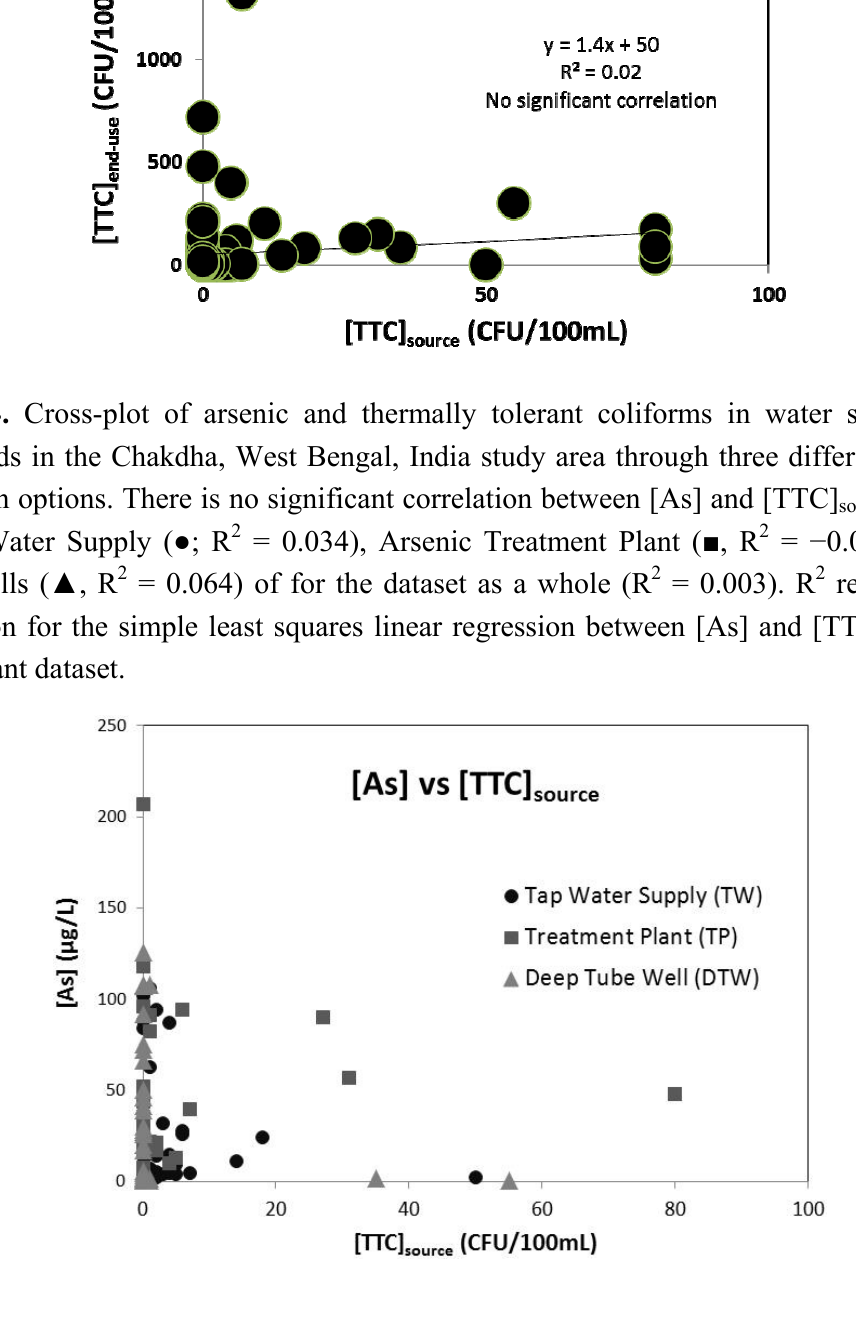
Figure 3. Cross-plot of thermally tolerant coliforms [TTC] in supplied and end-use drinking water from households in Chakda Block, West Bengal, India. The correlation between [TTC] and [TTC] is extremely poor—thus [TTC] is an extremely end-use source source poor predictor of [TTC] and hence of water-borne pathogen attributable health risks end-use >> [TTC] suggesting that to householders. For the majority of households, [TTC] end-use source post-supply contamination, either during transport to the household or within the household is an important process.